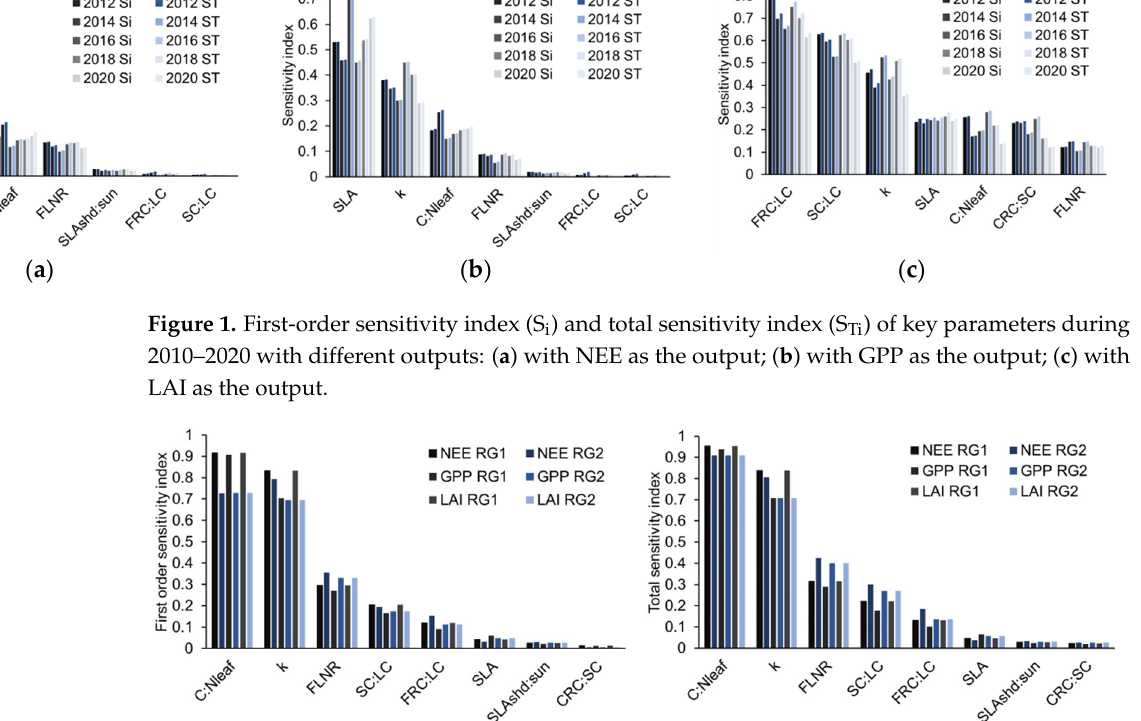
Figure 2. ( a ) First-order sensitivity index and ( b ) total sensitivity index in the ranges of ±10% per- turbation and ±20% perturbation of parameter values.